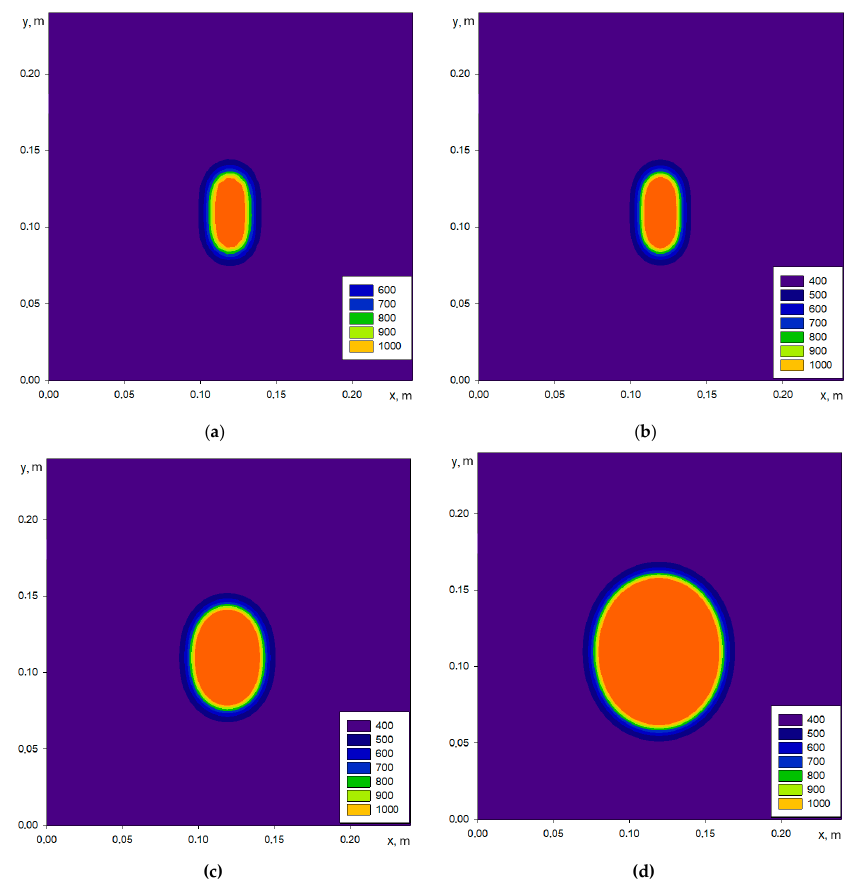
Figure 8. Isotherms on the surface of a wood layer in the vicinity of an igniting large firebrand ( 𝐿 = 50 mm, 𝐻 = 5 mm, 𝐷 = 16 mm) at different time: a — 1 s; b — 2 s; c — 5 s; d — 10 s;; wind